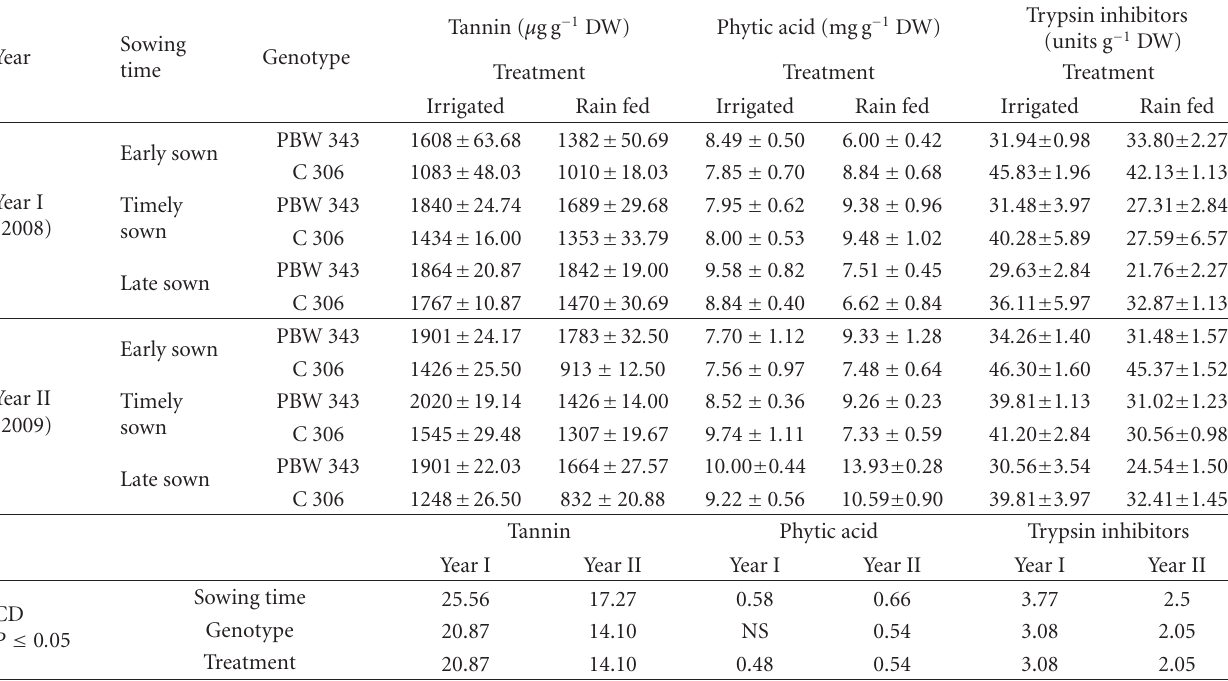
Table 4: E ff ect of sowing time on tannin ( μ gg − 1 DW), phytic acid (mgg − 1 DW), and trypsin inhibitor (units g − 1 DW) contents in mature grains of drought-susceptible (PBW 343) and drought tolerant (C 306) wheat genotypes grown under irrigated and rain-fed conditions. Values are mean ± standard deviation of three replicates; CD, critical di ff erence; NS, not significant; One inhibitor unit is defined as the quantity of inhibitor which inhibits 50% of trypsin